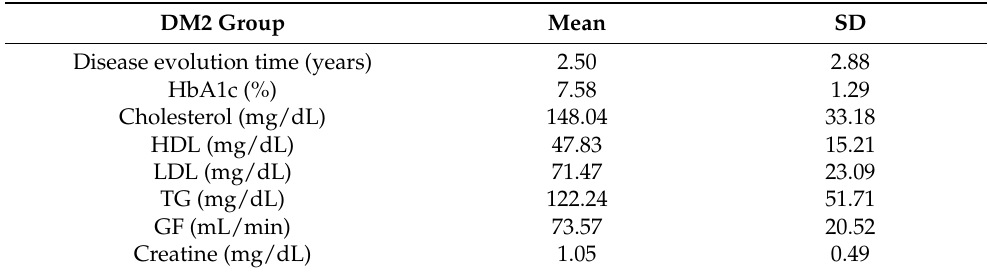
Table 1. Metabolic characteristics of type 2 diabetic (DM2) patients related to the duration and metabolic control of the disease. Abbreviations: HbA1c, glycosylated hemoglobin; HDL, high-density lipoprotein; LDL, low-density lipoprotein; TG, triglyceride levels; GF, glomerular filtration; SD, standard deviation. HbA1c values are expressed in a percent, cholesterol, TG, and creatine values in mg/dL and GF in mL/min. DM2 Group Mean SD Disease evolution time (years)